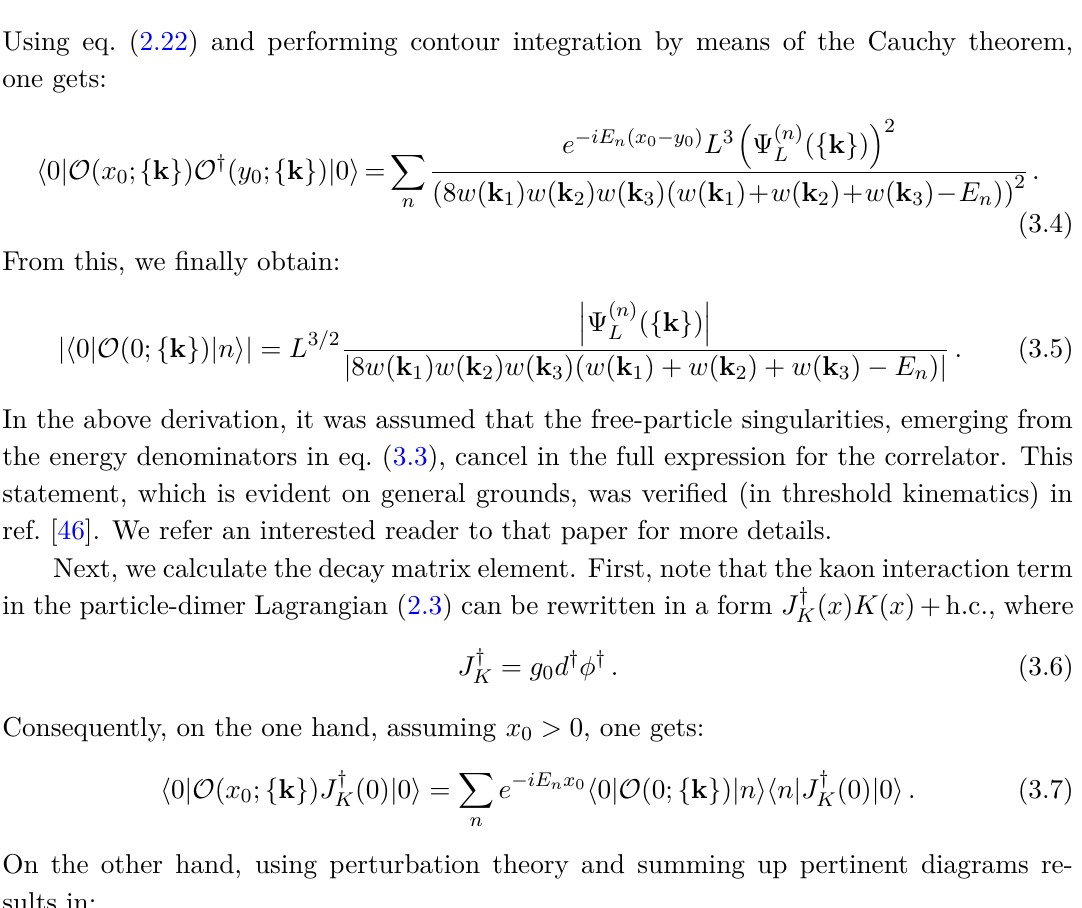
Figure 3 . The amplitude of the K → 3 π decay in the particle-dimer picture. The notations are the same as in figures 2 and 1. The cross denotes the vertex, which correspond to the decay of a kaon into a particle-dimer pair. This vertex comes with the coupling g 0